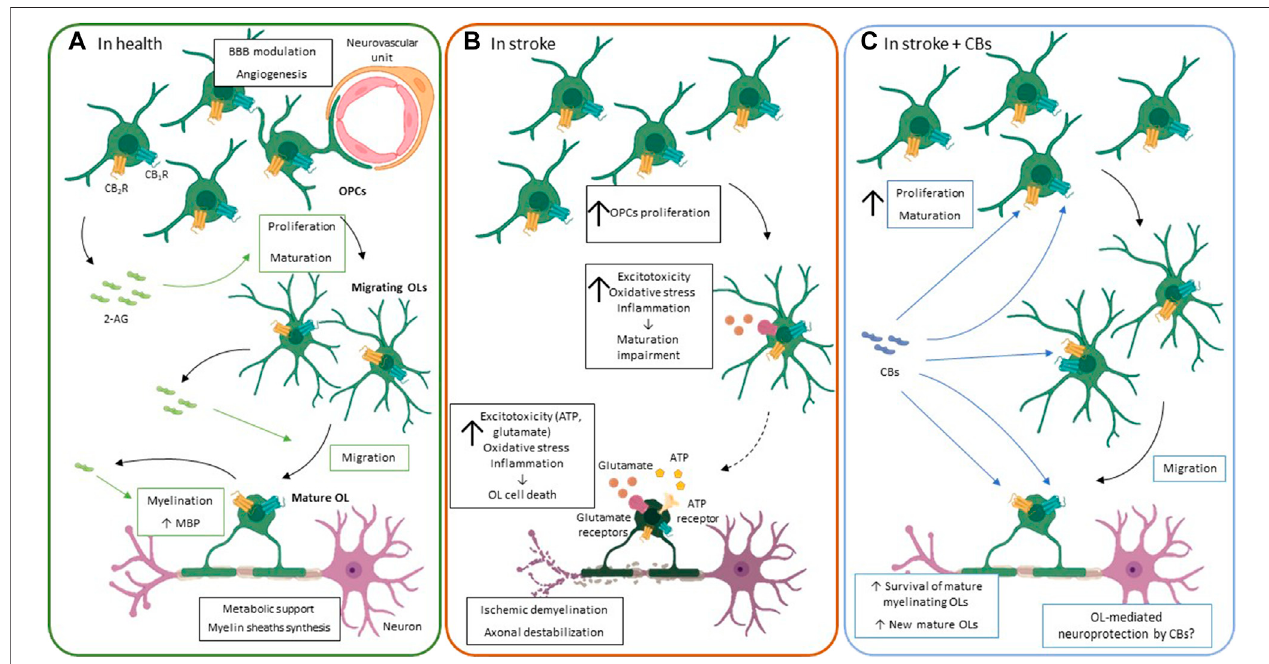
FIGURE 3 | The ECS functioning in oligodendrocytes. (A). Under physiological conditions, oligodendrocytes play a key role in the metabolic support of axons, myelin sheath synthesis and BBB regulation, among others. In the CNS, the endocannabinoid system, particularly 2-AG, is involved in oligodendrocyte proliferation, maturation,migrationandmyelinationofoligodendrocytes.2-AGisproducedinanautocrinemannerandexertsitseffectsthroughitsbindingtoCB 1 RandCB 2 R. (B). An ischemic event induces mature oligodendrocytes cell death due to the high sensitivity of these cells to: 1) glutamate and ATP receptor-induced excitotoxicity, 2) oxidativestress,i.e., high iron contentand de fi cient antioxidantsystem, and 3) in fl ammation, through release ofcytokines like TNF- α . In anattempt to repair the damage caused by stoke there is a strong oligoproliferative response. However, the maturation of these new oligodendrocytes is impaired, and they do not reach the mature myelinatingoligodendrocytestage,perpetuatingmyelinatingde fi citsthatcontributetomotorandsensitive impairmentobservedafterstroke. (C). Althoughtheevidence oftheoligoprotective potentialofCBsafter strokeisscarce, theyseemtoreduce themyelinationimpairment by1)reducingoligodendrocytecelldeathand2)promoting oligodendrocyte proliferation and maturation into myelinating oligodendrocyte after the insult. Green arrows and boxes: eCB-mediated effects; blue arrows and boxes: